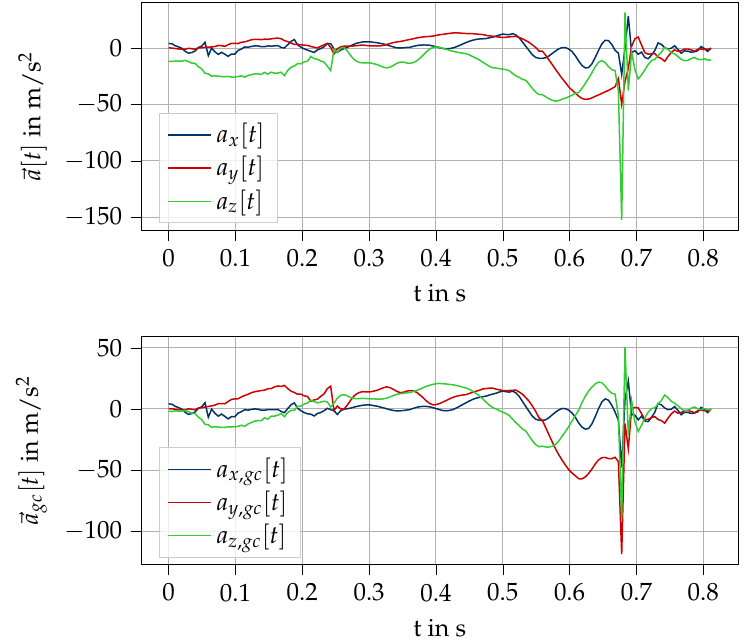
Figure A2. Visualization of the gravity removal in the acceleration signal for a sample stride of the heel sensor. The upper plot shows the raw acceleration (cid:126) a [ t ] segmented from MS to MS measured by the accelerometer. The lower plot shows the gravity corrected acceleration signal (cid:126) a gc [ t ] after rotating the raw acceleration by the quaternion sequence q [ n ] and removing gravity from the rotated signal. After the gravity removal, both the z -components of the acceleration at the first midstance ( t = 0s) and the second midstance ( t = 0.81s) have values close to